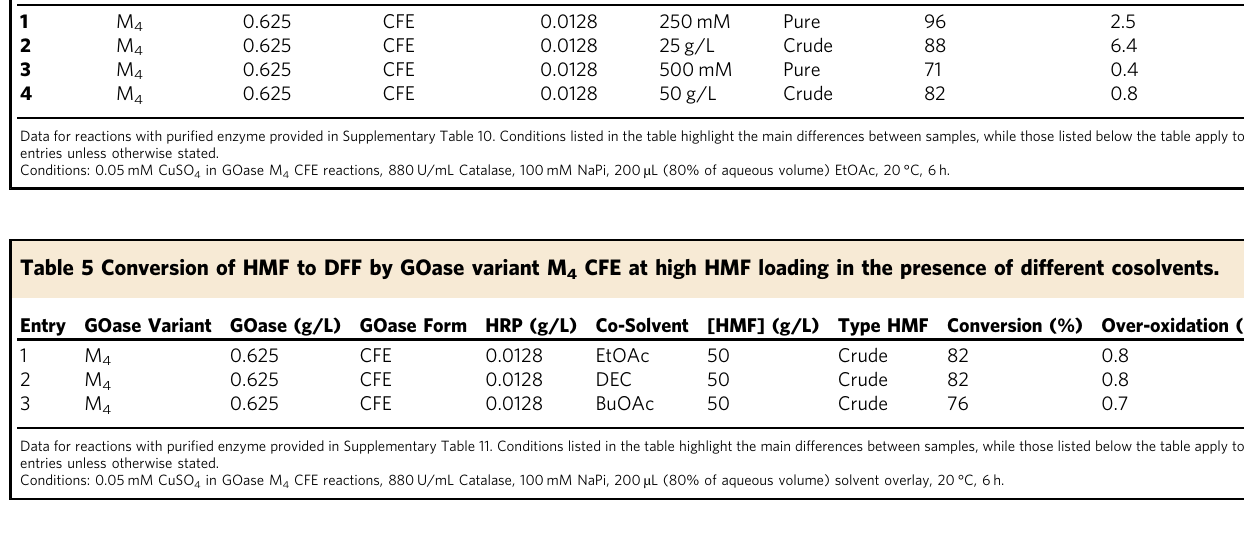
Table 4 Conversion of HMF to DFF by GOase variant M 4 CFE using EtOAc overlay at reduced incubation temperature.